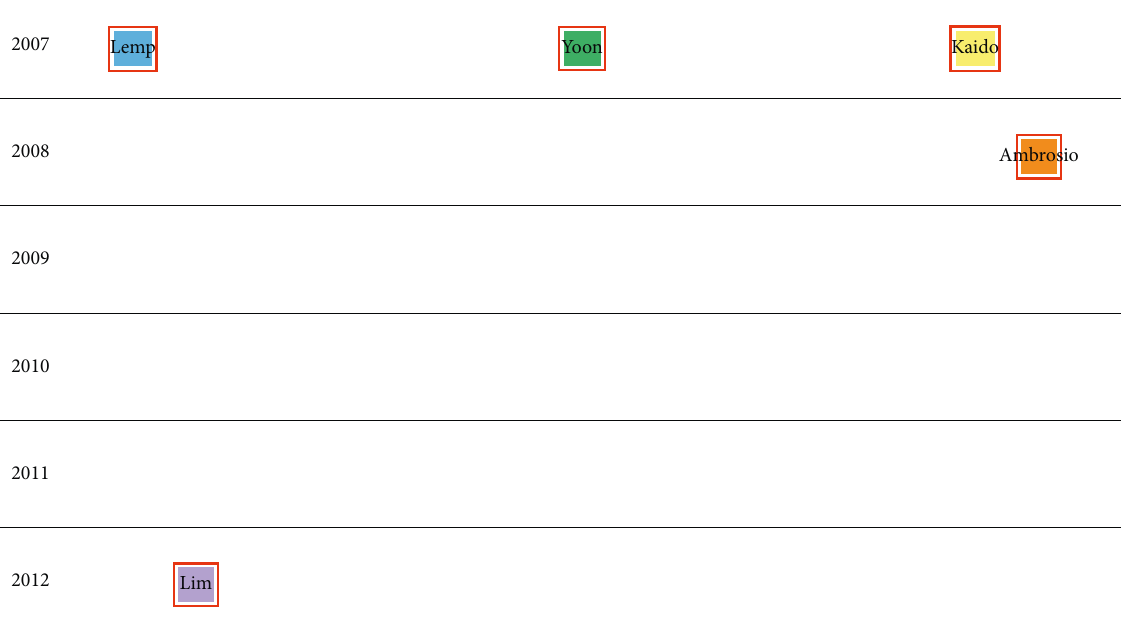
Figure 7: Relationships among different clusters.